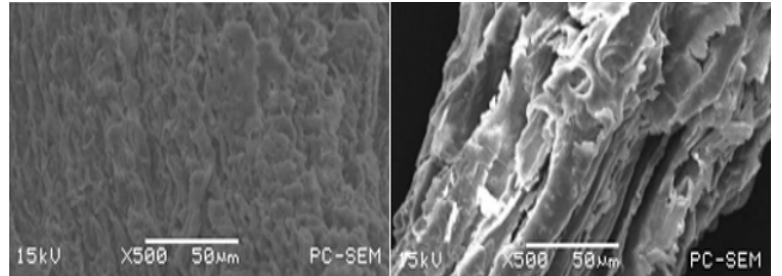
Figure 6. SEM micrographs of U-TS ( left ) and DNC-TS ( right ). [U-TS represents untreated TS; DNC-TS represents dilute NaOH–ChCl:UA-TA pretreated TS].